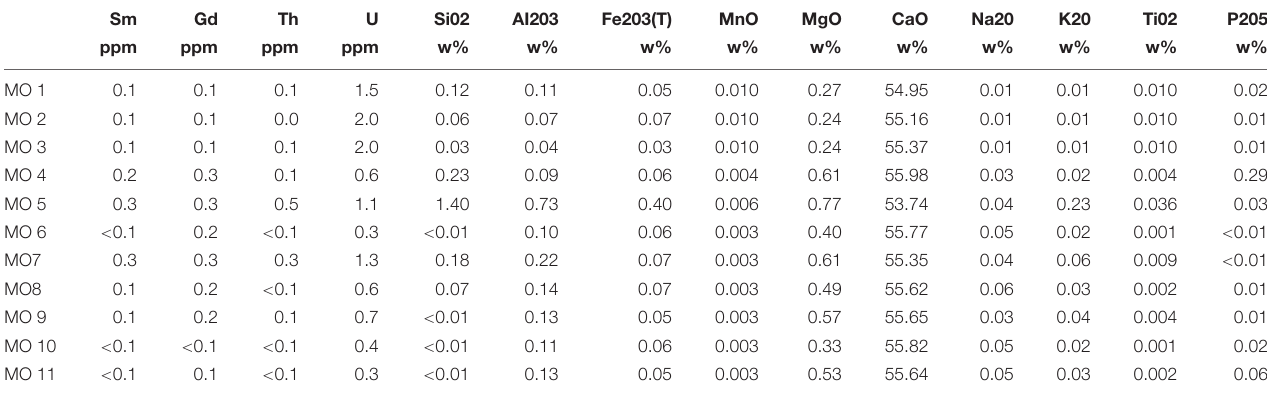
The here listed chemical components are the most important ones for the production rate of 36 Cl, i.e., also for the dating.